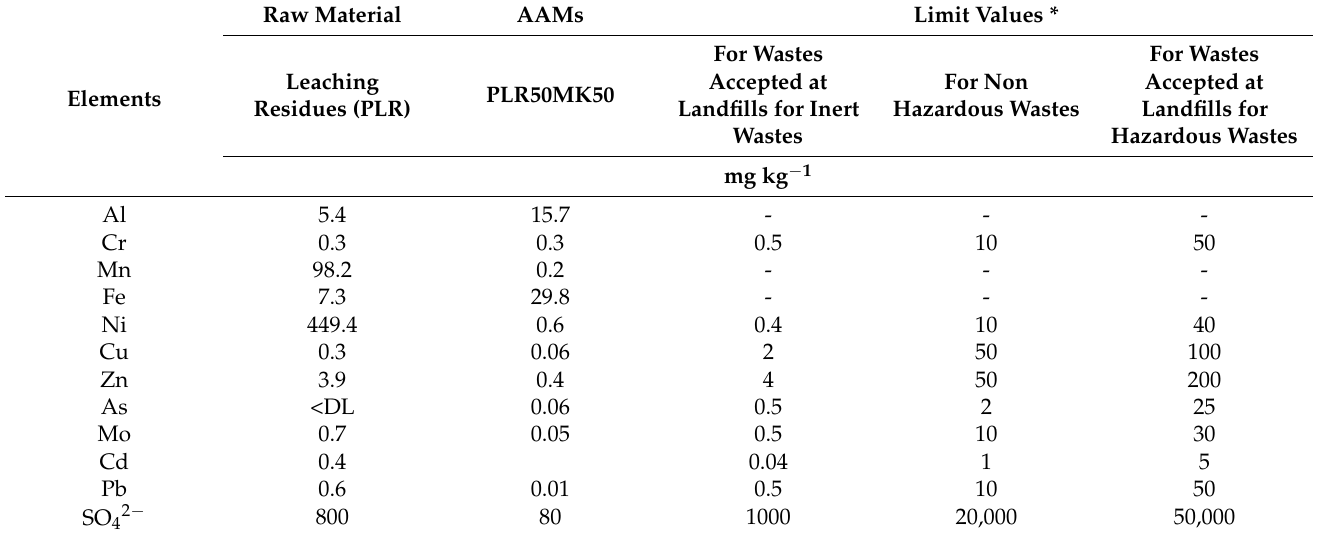
Table 9. EN 12457-3 results (L/S = 10 L kg − 1